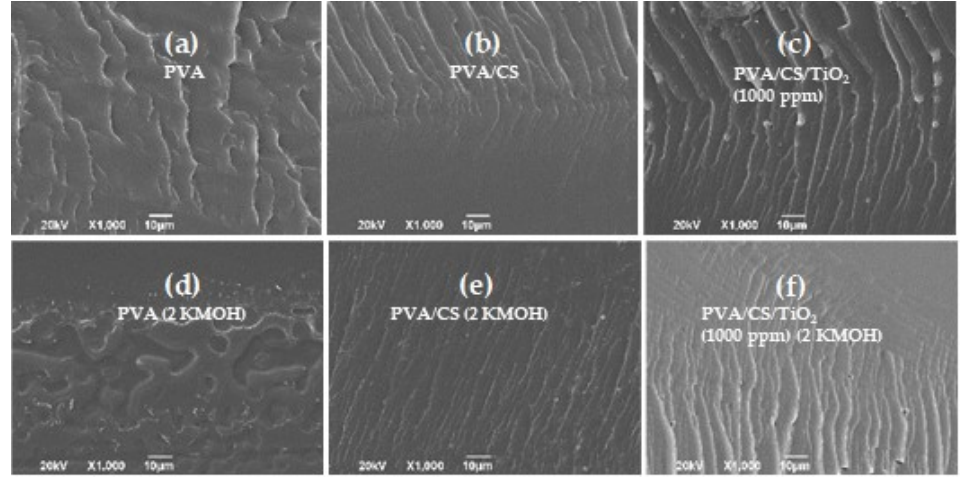
Figure 2. SEM micrographs of membrane cross-sections: ( a ) PVA; ( b ) PVA/CS; ( c ) PVA/CS compound (1000 ppm TiO 2 ); ( d – f ) the 2 M KOH doped membranes, respectively.